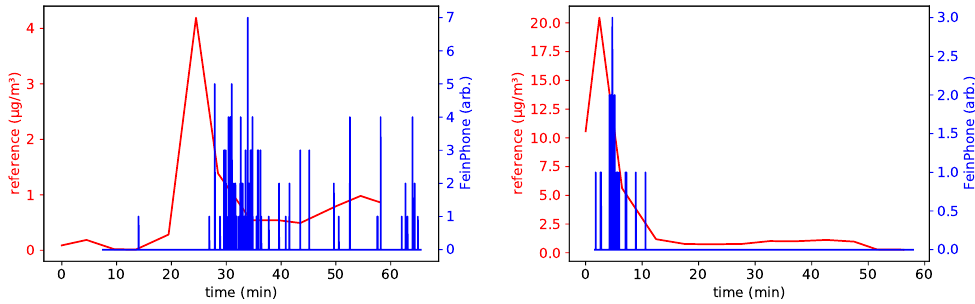
2.5 ) size − σ blur : 9, θ b / w : 50.0, (cid:104) (cid:105)